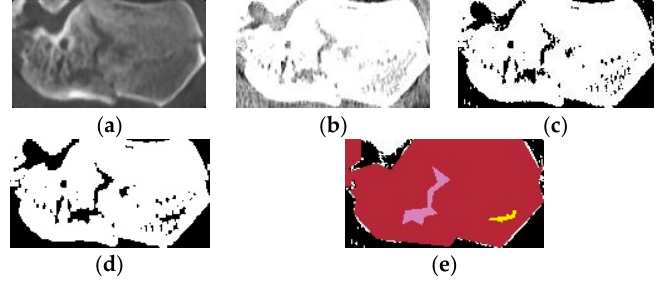
Figure 13. ( a ) Apply median filter; ( b ) Contrast enhancement; ( c ) Otsu segmentation; ( d ) Morphological operations; and ( e ) Fracture detection.